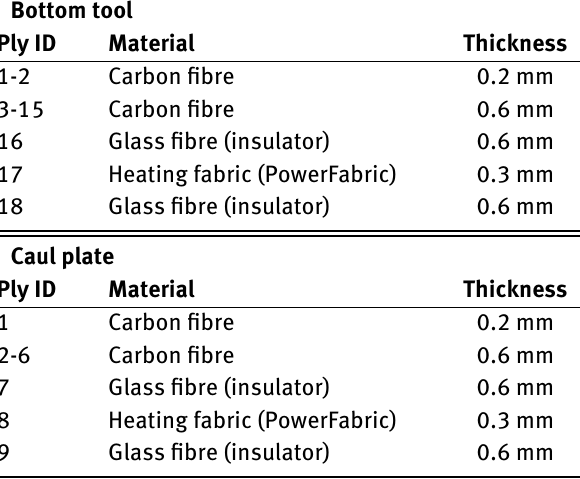
Table 1: Plybook for the developed self-heating tool. Bottom